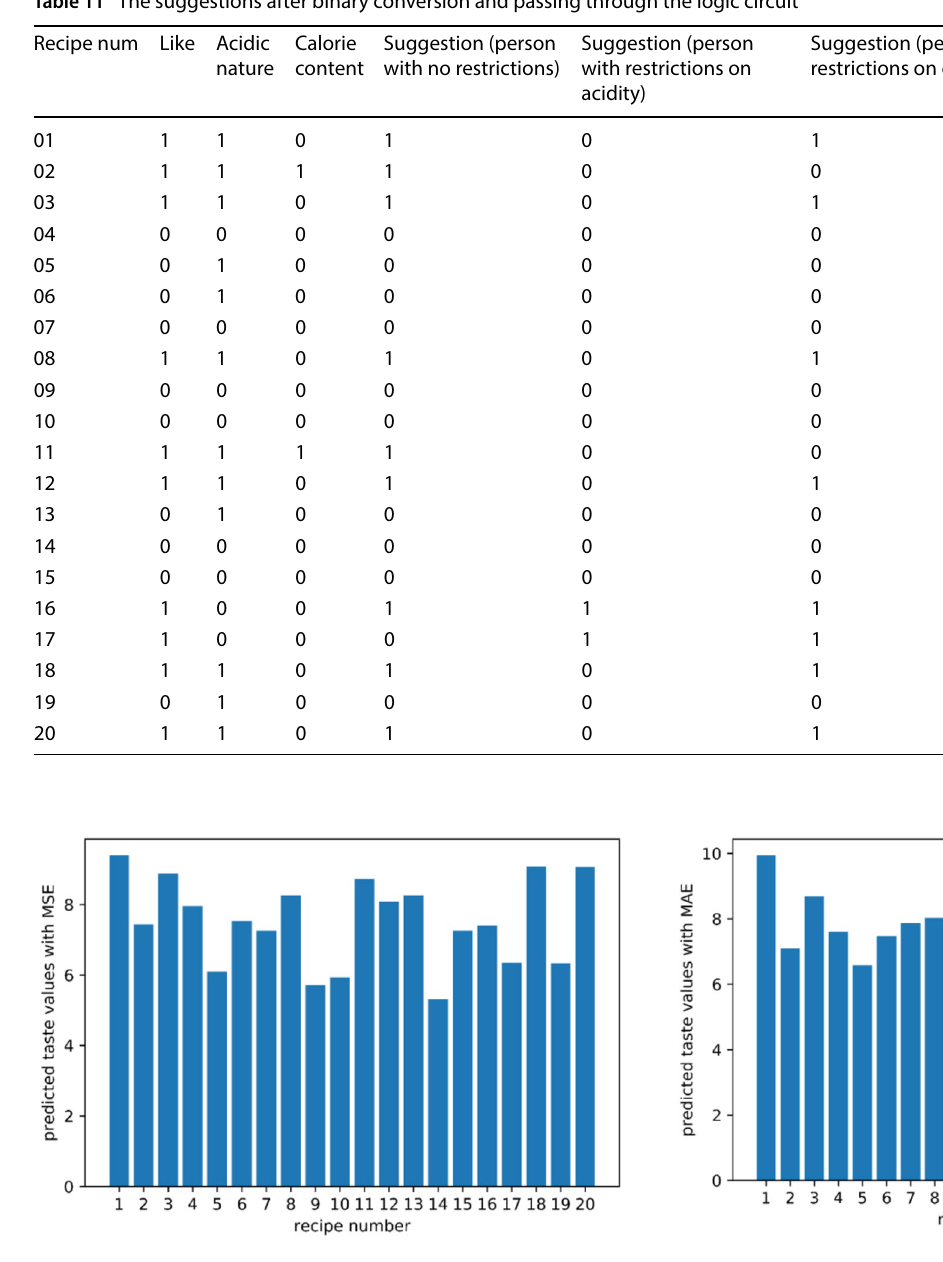
Fig. 4 Predicted taste ratings with ‘MSE’ or ‘mean squared error’ Fig. 5 Predicted taste ratings with ‘MAE’ or ‘mean absolute